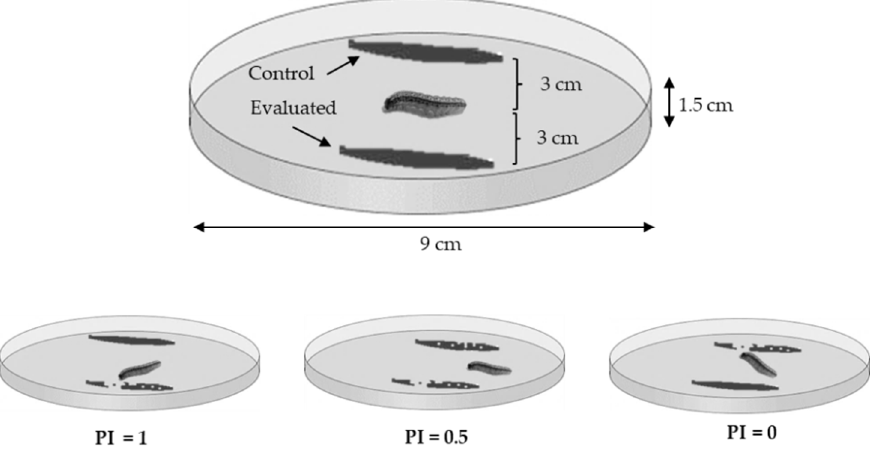
Figure 2. Device for feeding preference assessment of first instar larvae of S. frugiperda (not at scale).